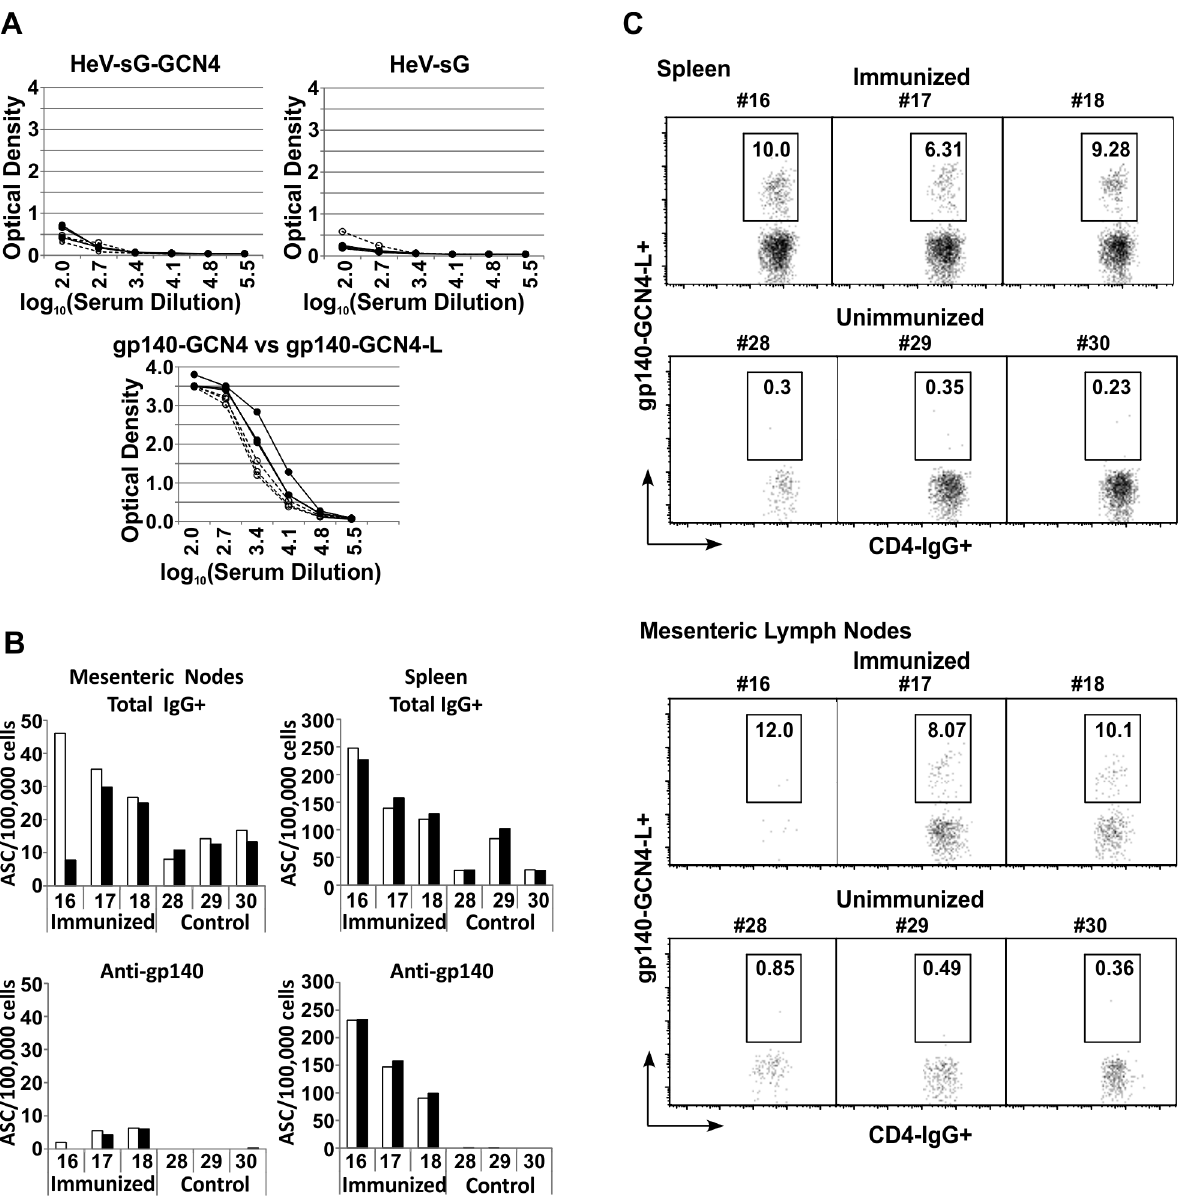
Figure 5. Envelope glycoprotein-specific antibody producing cells in lymph nodes and spleens. (A) Enzyme Linked Immunosorbent Assay (ELISA) of binding of rabbit sera to modified envelope glycoproteins. The presence of antibodies in the three rabbit sera obtained after 6 N immunizations against the GCN4 and linker components of gp140-GCN4-L was estimated by testing binding of antibodies in ELISA to proteins with ) and control ( # ) rabbits were tested for antibodies against Hendravirus soluble G and without GCN4 or linker. Upper panels: sera from immune ( protein (HeV-sG) with and without GCN4 carboxy-terminal fusions. No significant difference was noted in binding of immune and control sera to N either protein, suggesting lack of antibody response to the GCN4 component. Lower panel: Sera from immune rabbits were tested for binding to ) and R2gp140-GCN4 ( # ). No significant difference was noted in binding of the sera to the two proteins (tested by comparing R2gp140-GCN4-L ( optical densities values at log 10 (serum dilution)=3.4, the dilution with maximal splay of results using paired student T test, p=0.1); results show little or no binding to the linker peptide sequence. (B) Flow cytometry analysis of binding of peripheral blood B cells to R2gp140-GCN4-L. (C) ELISpot assay results on spleens and mesenteric lymph nodes of immune (rabbits 16, 17, and 18) and control (rabbits 28, 29, and 30) rabbits after immunizing dose 7. Cells were suspended by homogenization. Assays were performed in quadruplicate, except for testing of rabbit # 16 mesenteric lymph node cells that were tested in single wells. Open bars represent unstimulated cells and black bars represent stimulated cells. No significant differences were noted between the stimulated and unstimulated cell suspensions. doi:10.1371/journal.pone.0098060.g005 frequencies of B cells or plasma cells in spleens producing neutralizing. ELISpot assays were conducted to measure numbers antibodies that bound soluble R2 gp140-GCN4-L trimer. To the of antibody secreting plasma cells in spleens. Both total Ig secreting extent that this molecule resembles the authentic, functional Env cells and R2 gp140 trimer binding Ig secreting cells were markedly spike, antibodies that bind to the trimer are likely to be increased by immunization, and the majority of Ig secreting cells